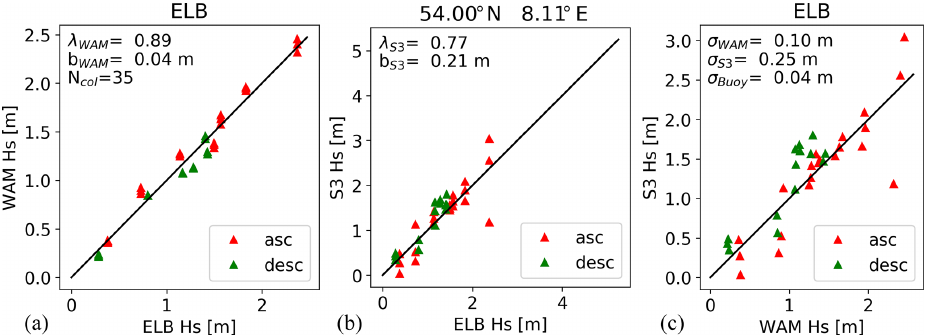
Figure 5. (a, b) Comparison of wave heights measured by the Elbe buoy with numerical model results (a) , and Sentinel-3A altimeter measurements (b) . The model and satellite data sets were corrected according to the calibration factors λ WAM and λ S3 and bias parameters b WAM and b S3 estimated in the triple collocation procedure (see Eq. 21). (c) Direct comparison between model and satellite data. Numbers are given for the estimated calibration factors, bias, and stochastic error standard deviations (cid:15) WAM , (cid:15) S3 , and (cid:15) Buoy . The red triangles refer to ascending (asc) satellite passes and the green ones to descending (desc) passes.